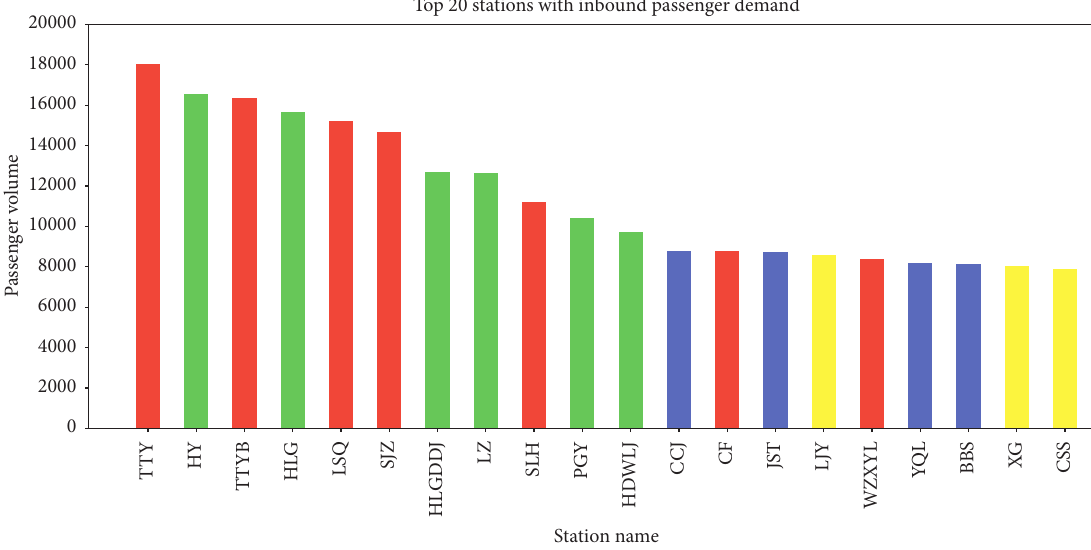
Figure 14: Top 20 stations with inbound passenger